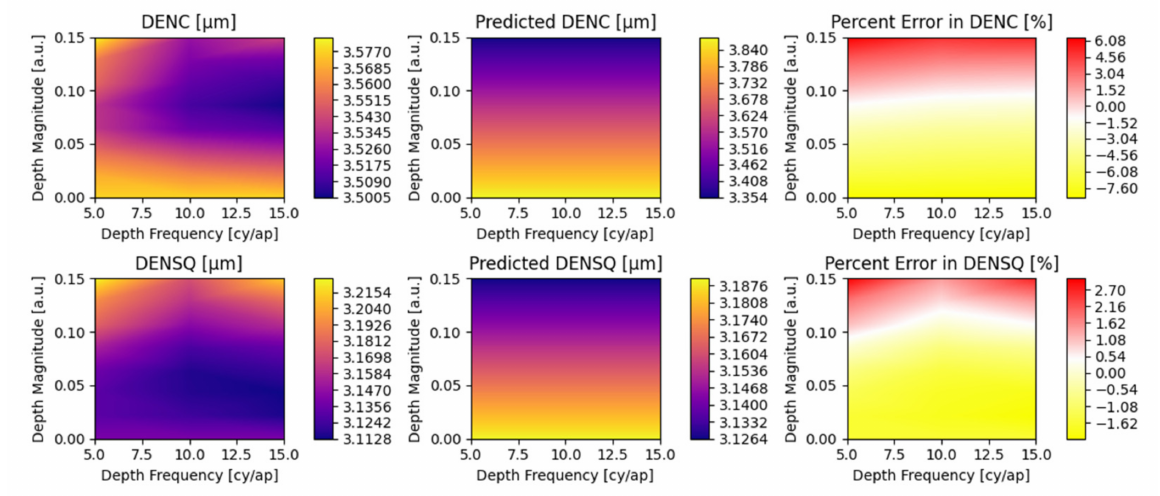
Figure A16. Depth Frequency vs. depth magnitude. ( κ = ω = δ = 0, ξ = 10, σ = 0.05, θ = 45 ◦